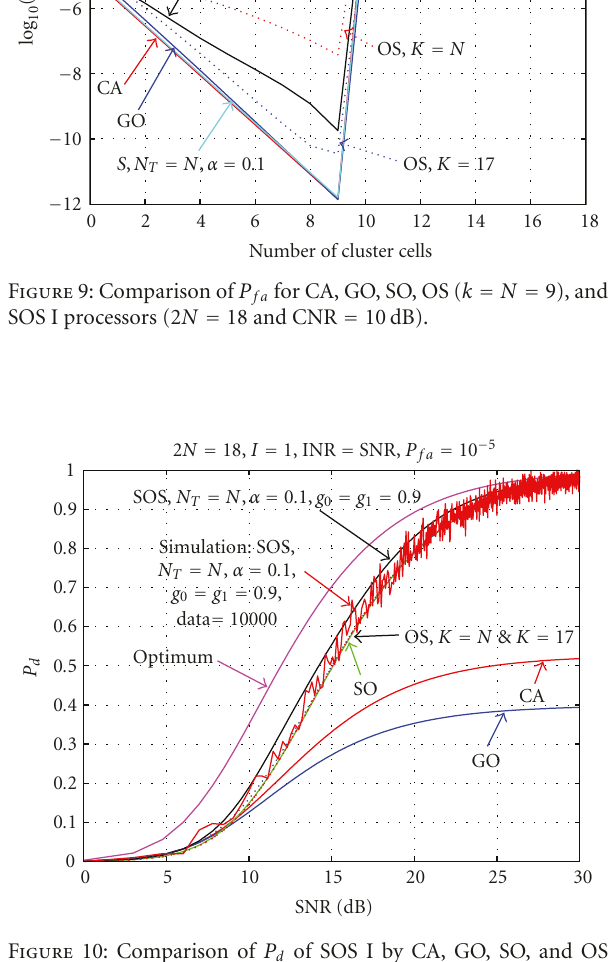
Figure 10: Comparison of P d of SOS I by CA, GO, SO, and OS ( k = N and k = 17) in the case of one multiple targets (INR = SNR) for P fa = 10 − 5 and 2 N = 18.